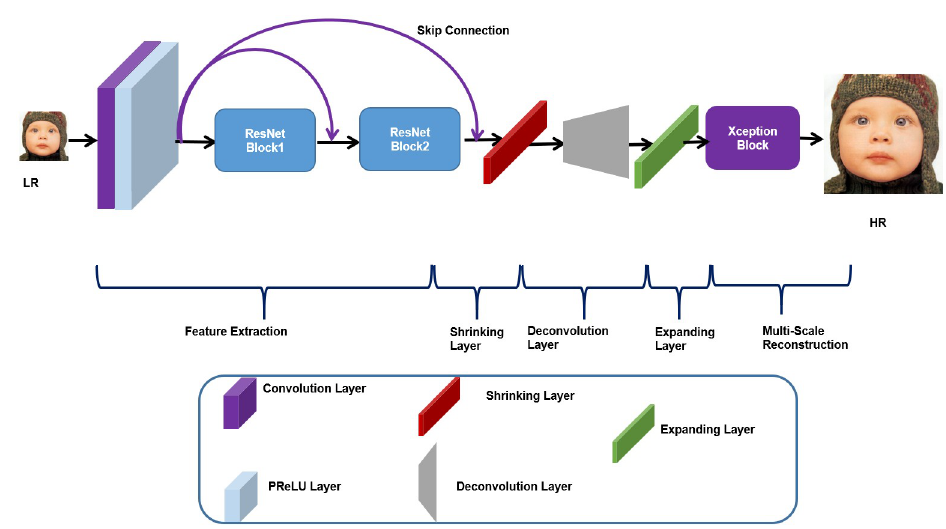
Fig 1. Proposed network architecture of Xception based single image super-resolution